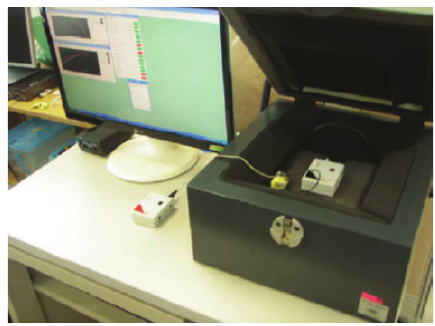
Figure 6: Performance characteristic test setup.